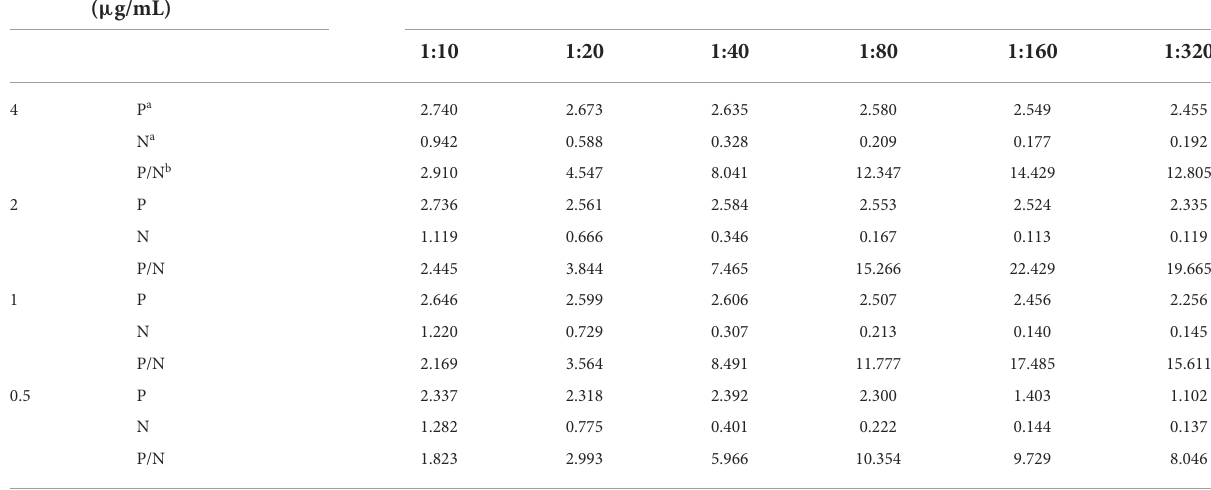
TABLE 1 Determination of the optimal reaction conditions of the